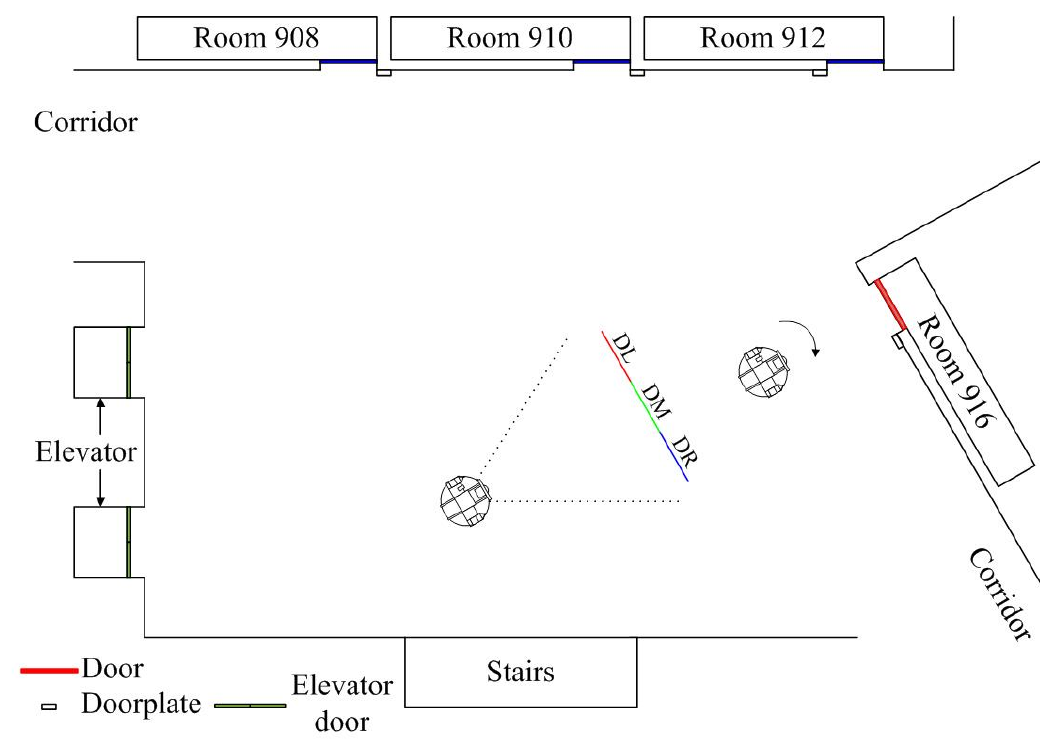
Figure 22. If the verification result is positive, the robot turns right.